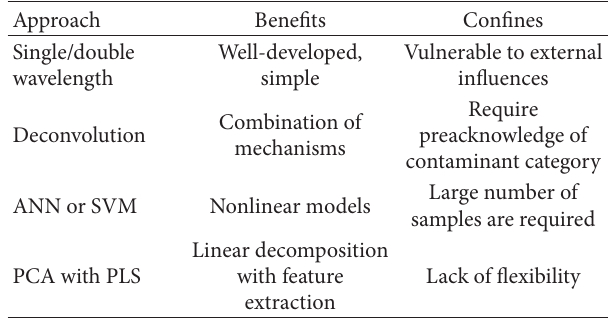
Table 1: Summary of traditional approaches for water-quality event detection with